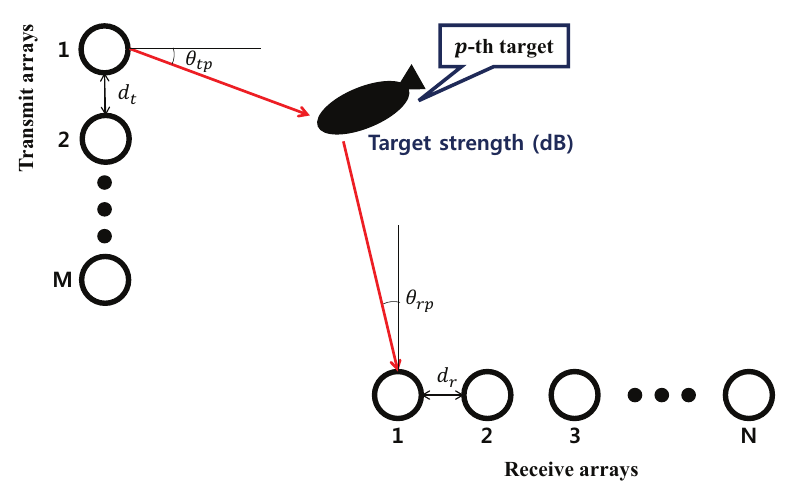
Figure 2. The simulation structure based on the bistatic multiple input multiple output (MIMO)